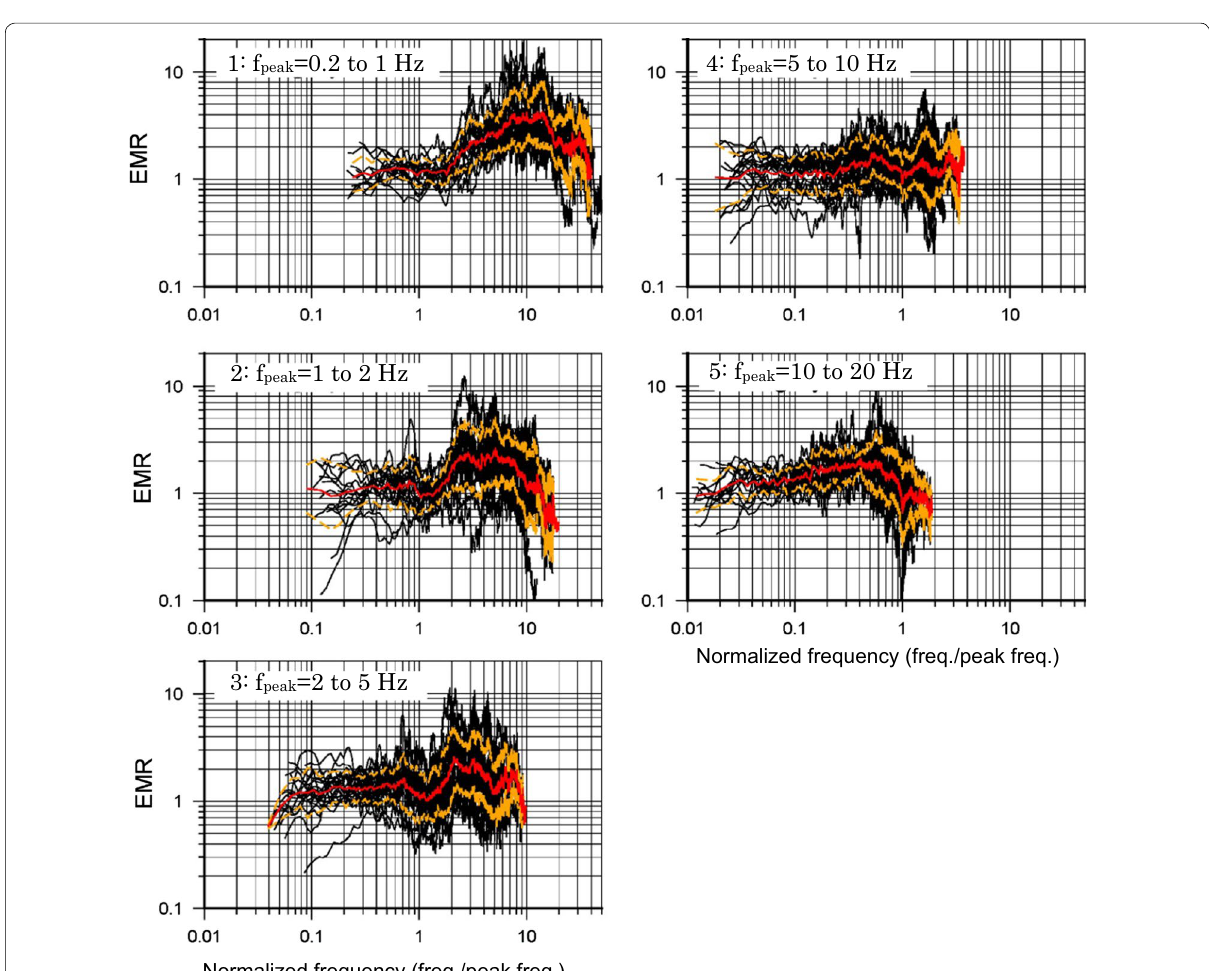
Fig. 11 Average EMRs with normalized frequency categorized by peak frequency ranges. Peak frequency range is: top left: 0.22–1.0 Hz, middle left: 1.02–2.0 Hz, bottom left: 2.0–5.0 Hz, top right: 5.02–10.0 Hz, and middle right: 10.02–20.0 Hz. Red lines are the log-averaged values, which are used for pEHVR calculation, while orange lines are the average one standard deviation. The horizontal axis is the normalized frequency for each ± category. We can see that significant correction factors are needed in the normalized frequency range higher than 2 for Categories 1–3